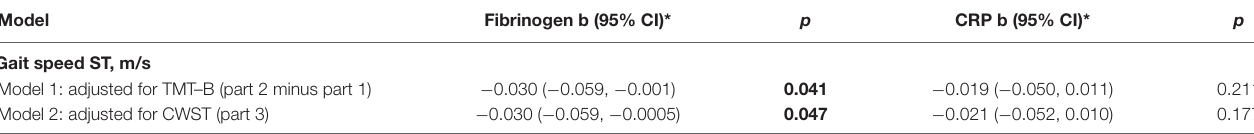
TABLE 3 | Associations between inflammation markers at baseline and gait speed under ST, with further adjustment for executive functions at 20-year